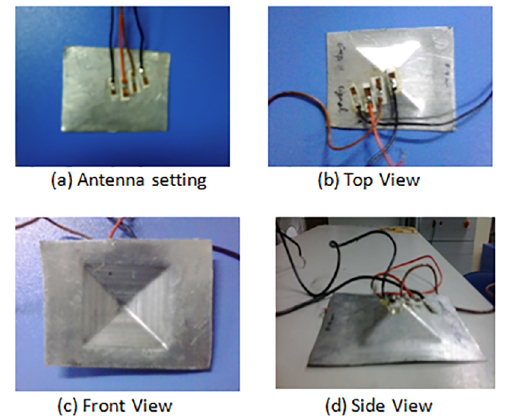
Figure 4. a Actual representation of Antenna before forming, 4b-d different view of formed square pyramid frusta.